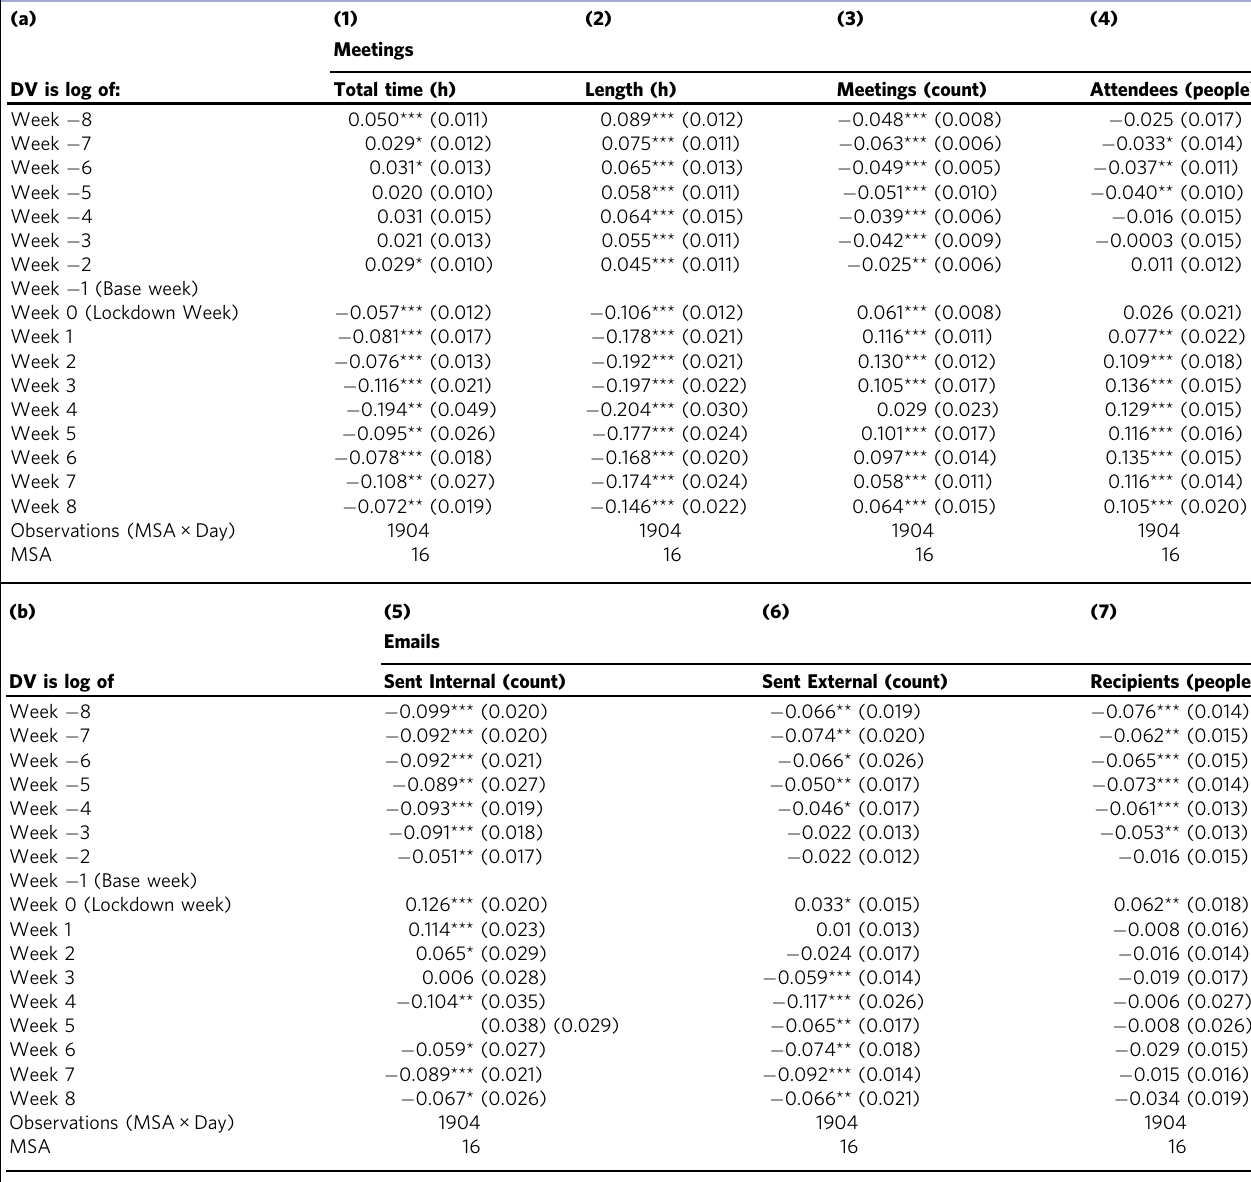
Table 2 (a) Meeting regression results over time a . (b) Email regression results over time b